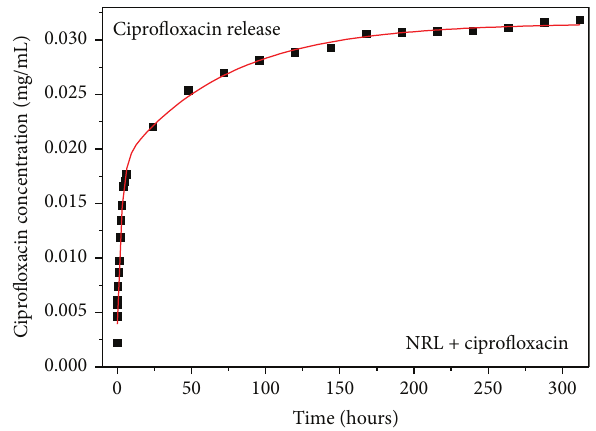
Figure 4: Ciprofloxacin release as a function of time for NRL membrane prepared at room temperature. Notice that the drug concentration reaches a plateau after approximately